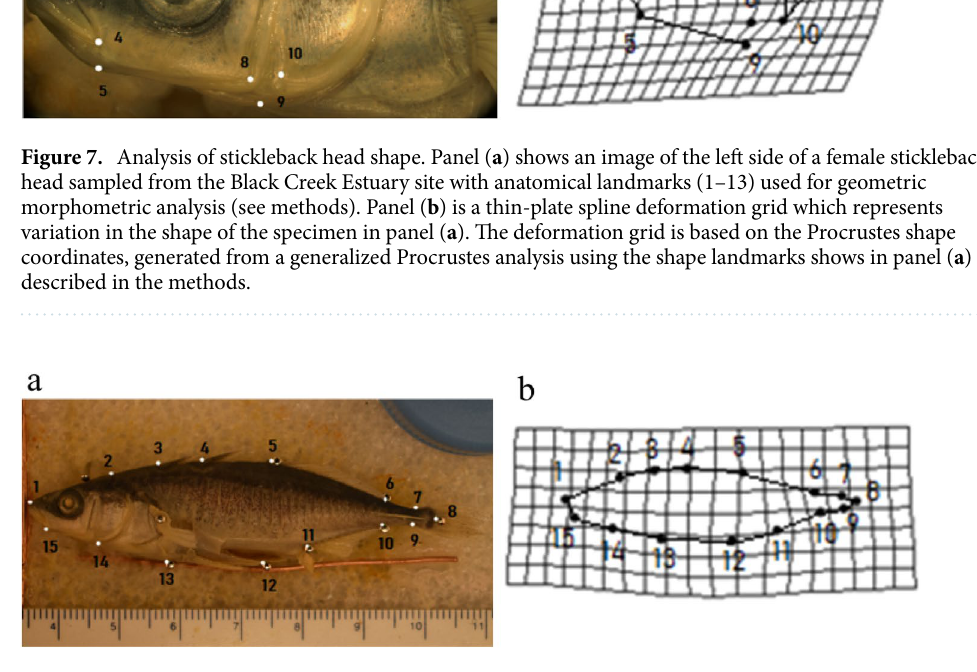
plate morphs: low (10 or fewer plates with no keel), partial (11–25 plates, missing plates only on the middle of the body), or complete (26–35 plates) 1 . Yet, because of the small number of partial and low morphs, we combined the two into one category of non-complete plate morphs. Geometric morphometrics. The original images were converted into tps format using the software tps. Util version 1.61, and then organized into files for superimposition 95 . The tps images were uploaded into tps.Dig version 2.05 to digitize landmarks on the head and body shots 96 . For headshots, 13 anatomical landmarks were placed around the left side of the head (Fig. 7), which were adapted from landmarks used in previous studies 5,86 . For body shots, 15 landmarks were placed on the left side of the body (Fig. 8). The body landmarks were also based on previous studies 30,49 . The landmarks used for geometric morphometric analysis of head shape were: 1. Anterior tip of the upper lip; 2. Anterior tips of the snout; 3. The nostril; 4. The axis of the jaws; 5. Posterioventral edge of angular; 6. Anterior edge of the eye; 7. Posterior edge of the eye; 8. Posterioventral edge of the third suborbital; 9. Anterioventral edge of the interoperculum; 10. Anterioventral edge of the operculum; 11. Anteriodorsal edge of the operculum; 12. Posteriodorsal edge of the operculum; 13. Posterior extant of the supraoccipital (Fig. 7). The bone description of landmarks was based on 24,86 . The landmarks used for geometric morphometric analysis of body shape were: 1. Anterior tip of the upper lip; 2. Posterior extant of the supraoccipital; 3. Anterior base of the first dorsal spine; 4. Anterior base of the second dorsal spine; and 5. Anterior base of the third dorsal spine; 6. Posterior edge of the dorsal fin; 7. Anteriodorsal edge of the caudal fin; 8. Caudal end of the caudal keel; 9. Anterioventral edge of caudal fin base; 10. Posterior edge of ventral fin; 11. Anterior edge of anal fin; 12. Posterior process tip of the pelvic girdle; 13. Anterior process tip of the pelvic girdle; 14. Ventral tip of pectoral girdle; 15. Posterior edge of angular 59 (Fig. 8).